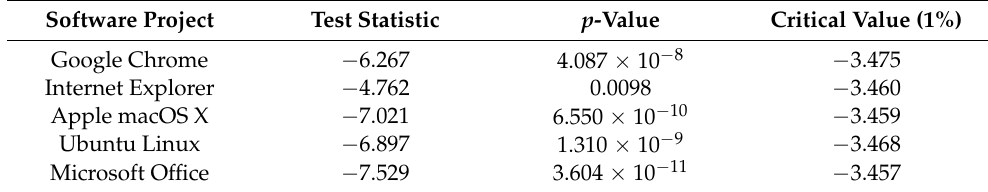
Table 5. Dickey–Fuller test on first-order differenced